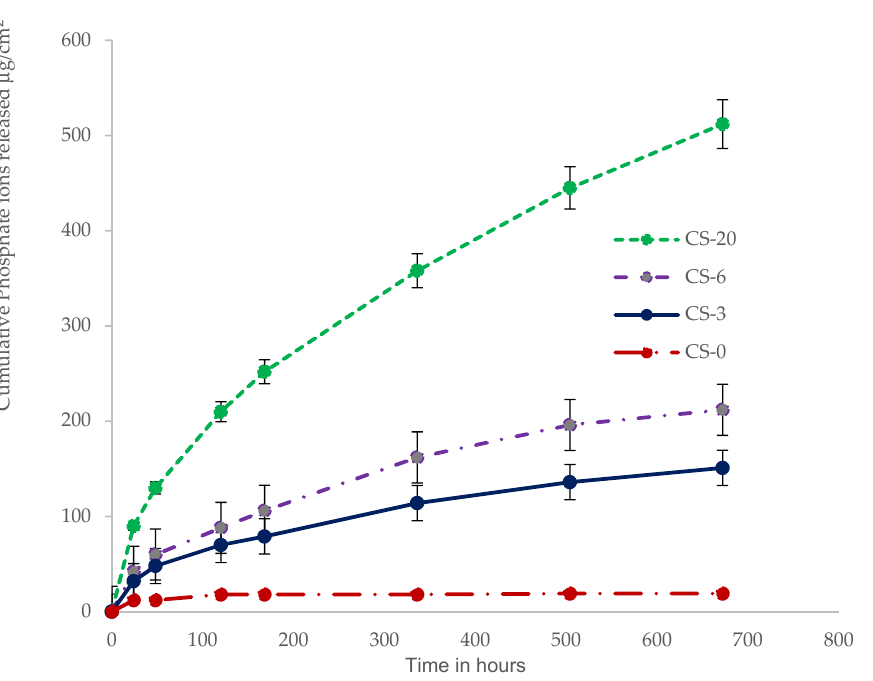
Figure 3. Cumulative release profile data of calcium ions from the composite specimens show esca- lating release of calcium ions with increasing percentages of MCP.